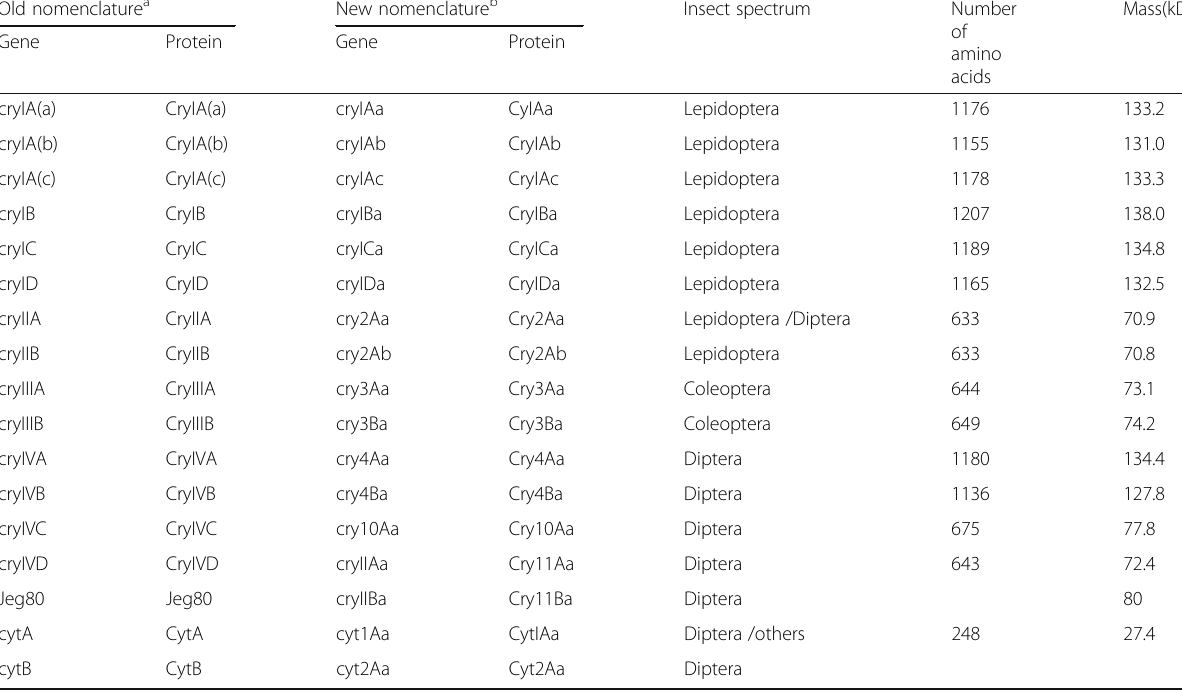
Table 1 Nomenclature for representative insecticidal proteins and their encoding genes from Bacillus